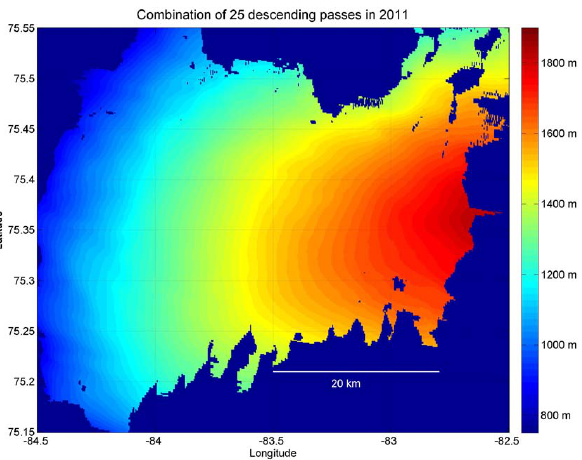
Fig. 8. Results from 25 descending passes have been combined to Figure 8. Results from 25 descending passes have been combined to create a DEM of the create a DEM of the western slopes of the Devon Ice Cap. Colour western slopes of the Devon Ice Cap. Colour has been used to indicate height in meters. The has been used to indicate height in metres. The uneven edges of the uneven edges of the DEM at the north and south edges are due to the relatively large along- DEM at the north and south edges are due to the relatively large track slope and the resulting poor solution often indicated by lower data coherence and higher along-track slope and the resulting poor solution often indicated by phase noise. lower data coherence and higher phase